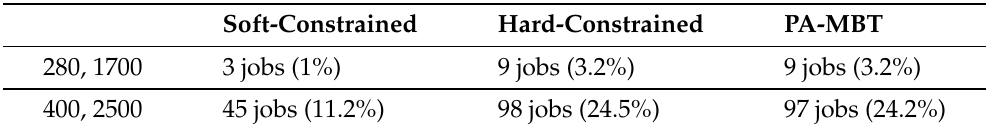
Table 3. Number of rejected DL training jobs for workloads of (280 training jobs, 1700 inference reqs/min) and (400 training jobs, 2500 inference